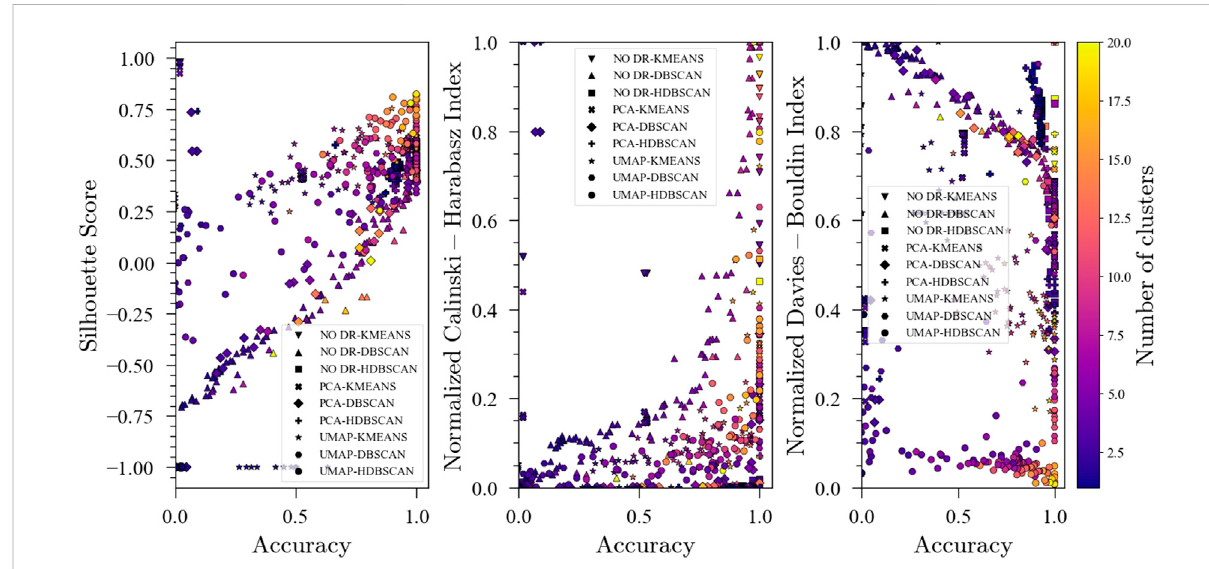
FIGURE 8 EvolutionoftheSilhouetteScore,Davies-BouldinIndexandCalinski-HarabaszIndexwithaccuracyduringoptimizationforthepyrolysisreactor with 3 labeled